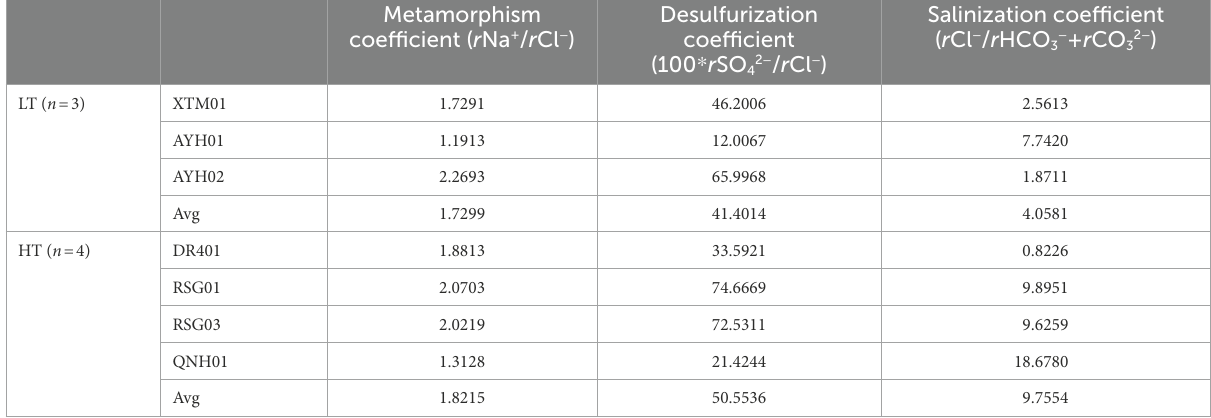
TABLE 1 The characteristic hydrochemical coefficient of thermal storage of hot springs in the northeast margin of the Qinghai Tibet